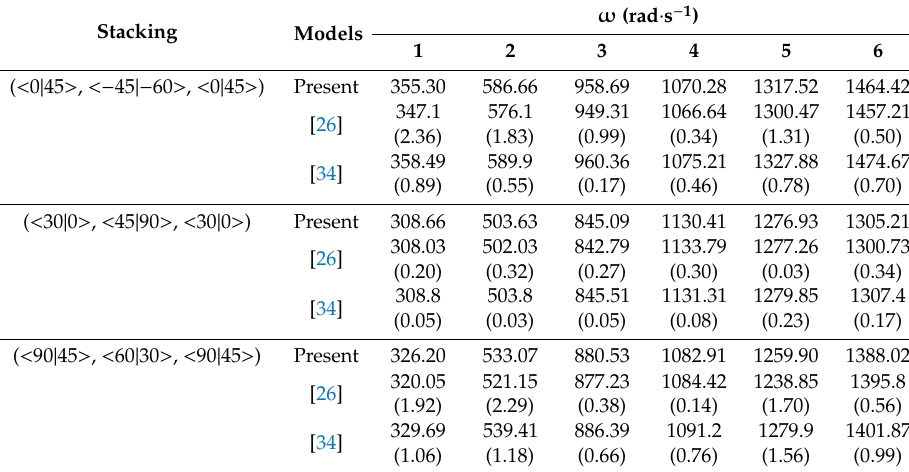
Table 5. Natural frequencies (rads · s − 1 ).